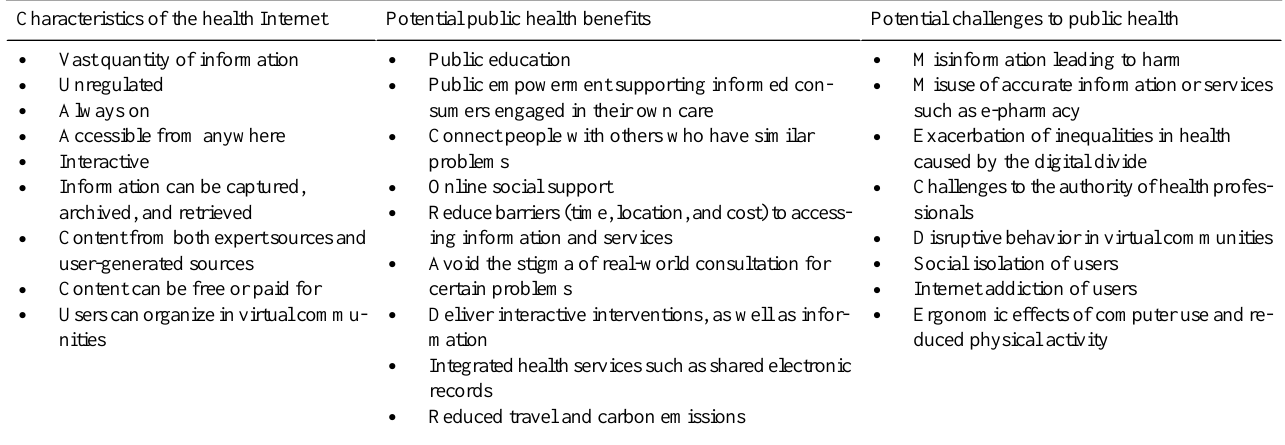
Table 1. Theoretical characteristics and potential public health benefits and challenges of health-related Internet